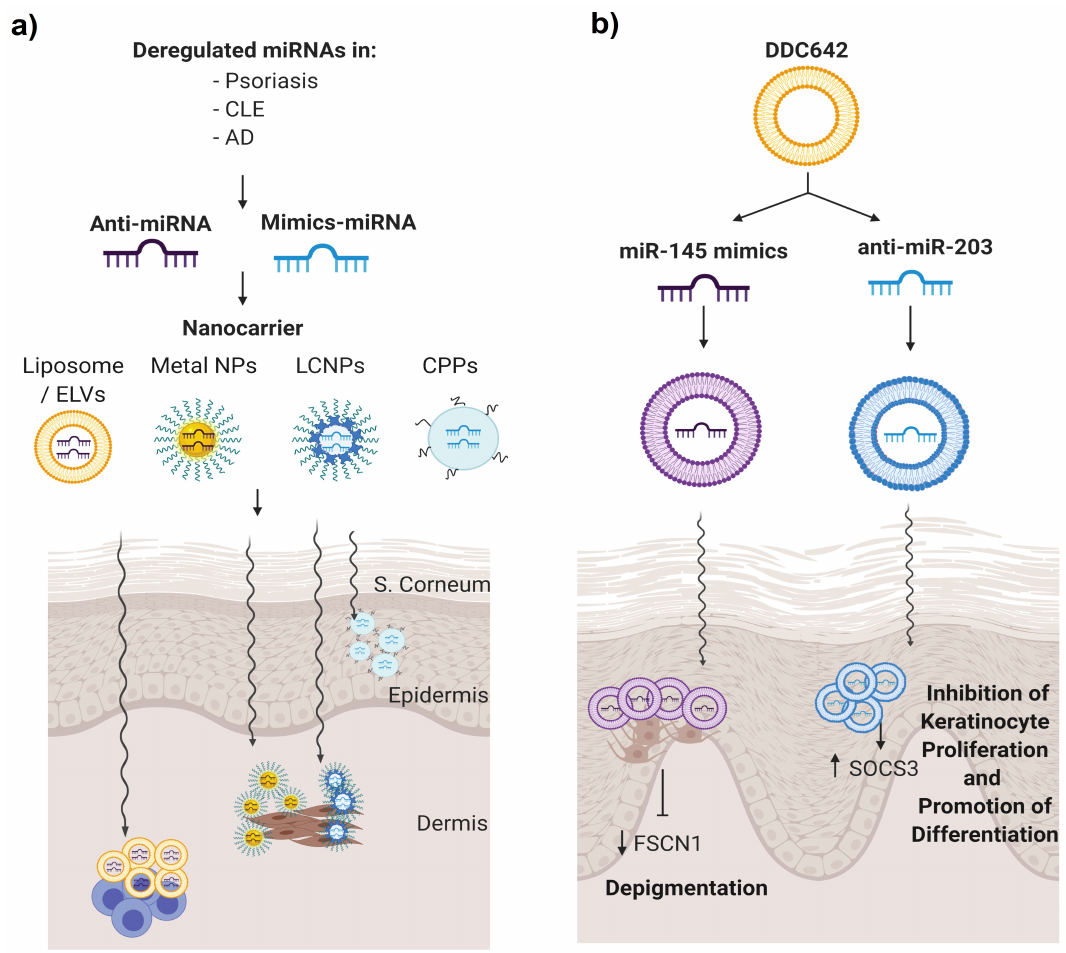
Figure 4. miRNA therapeutics for skin autoimmune diseases. ( a ) Dysregulated miRNAs in skin disorders may be potential candidates to be modulated to re-establish their expressions to normal conditions. Within this approach, anti-miRNA or mimics miRNA are encapsulated into nanovehicles to favour their penetration, avoid its degradation and be able to target the desired cells. ( b ) Deregulated miRNA in psoriasis miR-203 and miR-145 were selected, and therefore, anti-miR203 and miR-135 mimics were encapsulated in DDC624 liposome complexes, respectively, in a psoriasis tissue model.